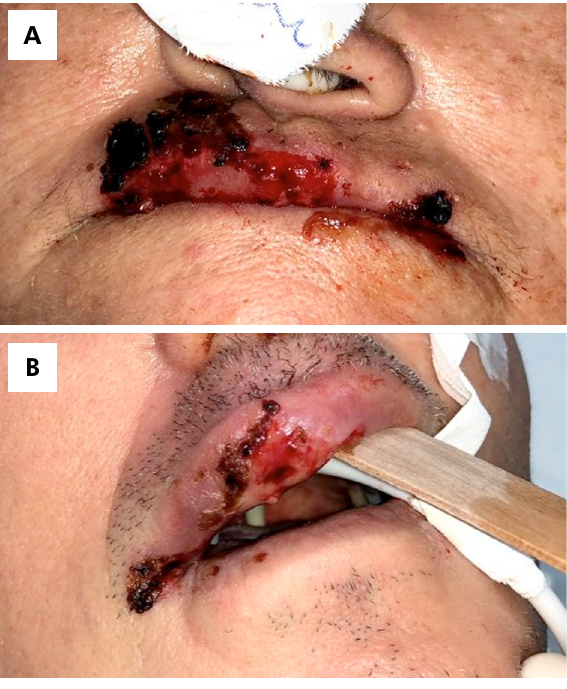
Figure. (A and B). Labial hemorrhagic ulcers in patients submitted to tracheostomy on day 5-7